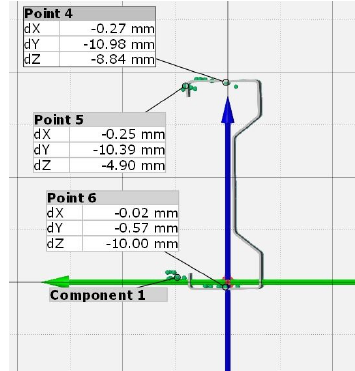
Figure 9. Displacements of selected cross-section points in the middle of the beam span under a load of 25 kN.